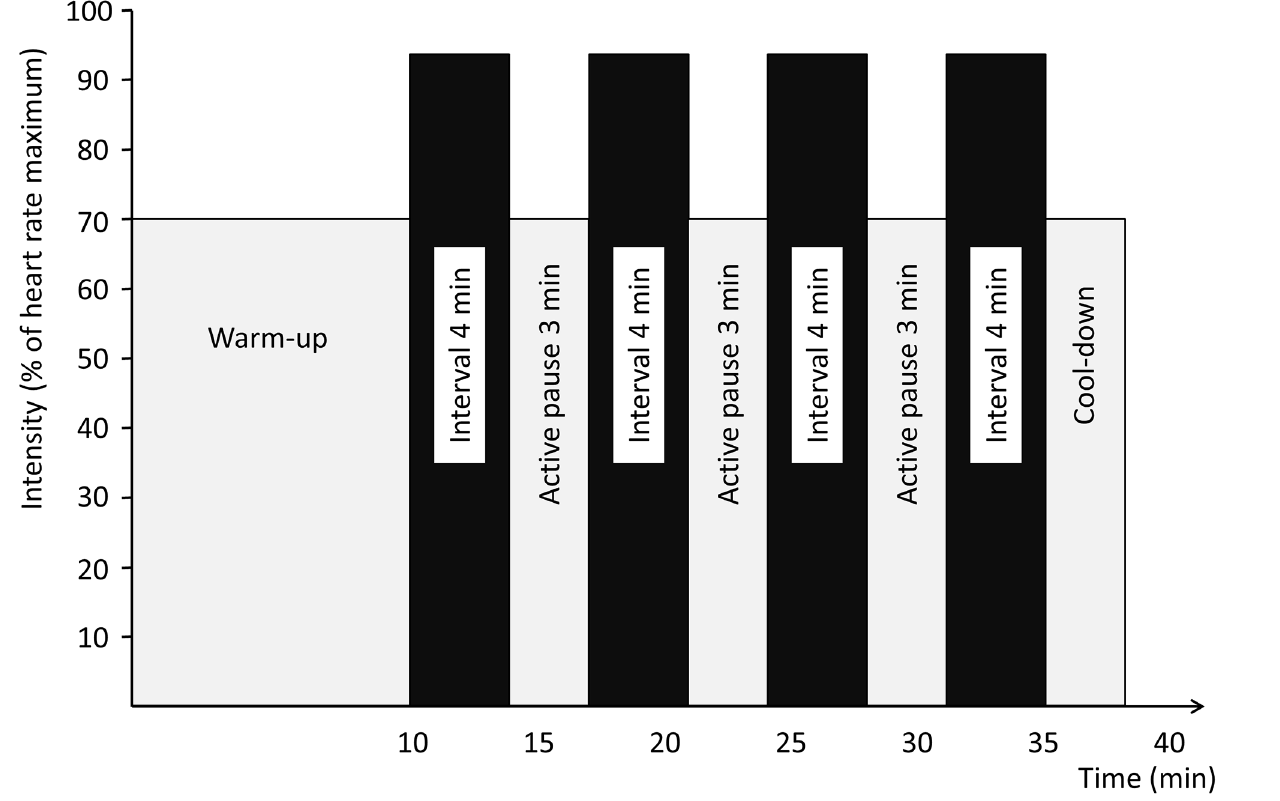
Fig 2. Four times four minutes high intensity interval